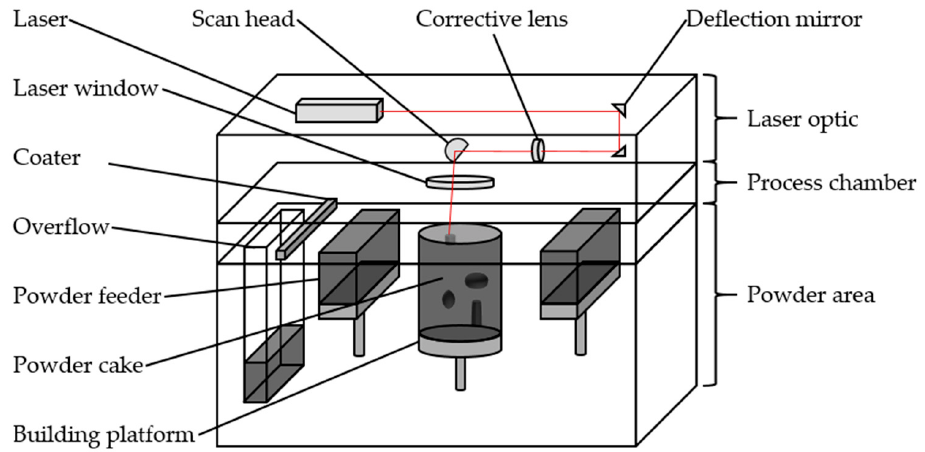
Figure 1. Design of an SLS system using the example of the Sintratec S2 laser sintering system from Sintratec AG. Subdivision of the SLS system into three areas.